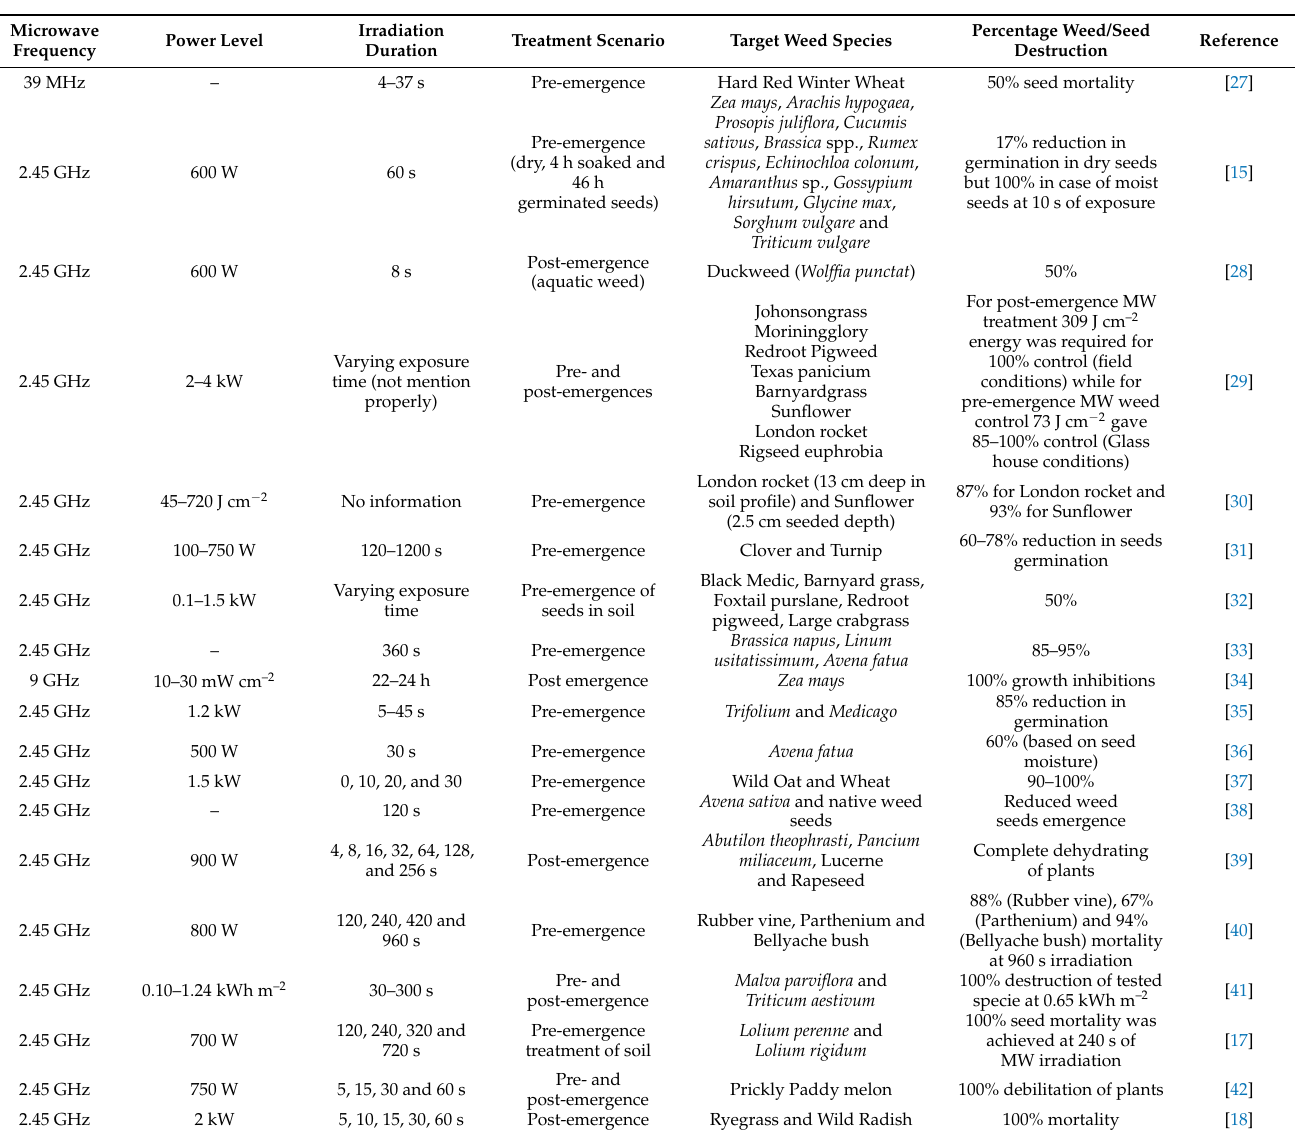
Table 1. Summary of microwave-based weed management